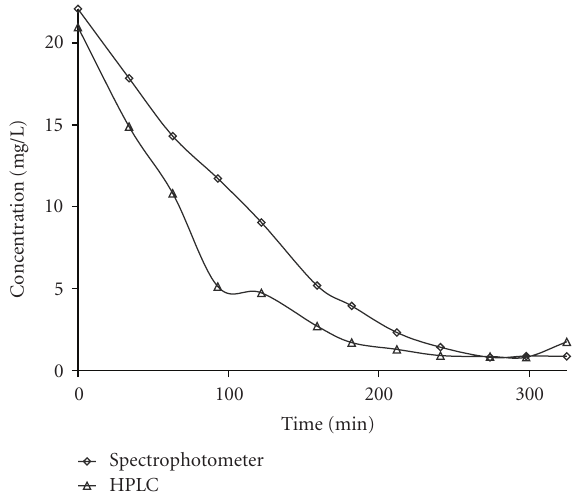
Figure 10: Comparison of phenol concentration as determined by spectrophotometry analysis and HPLC (40 fin